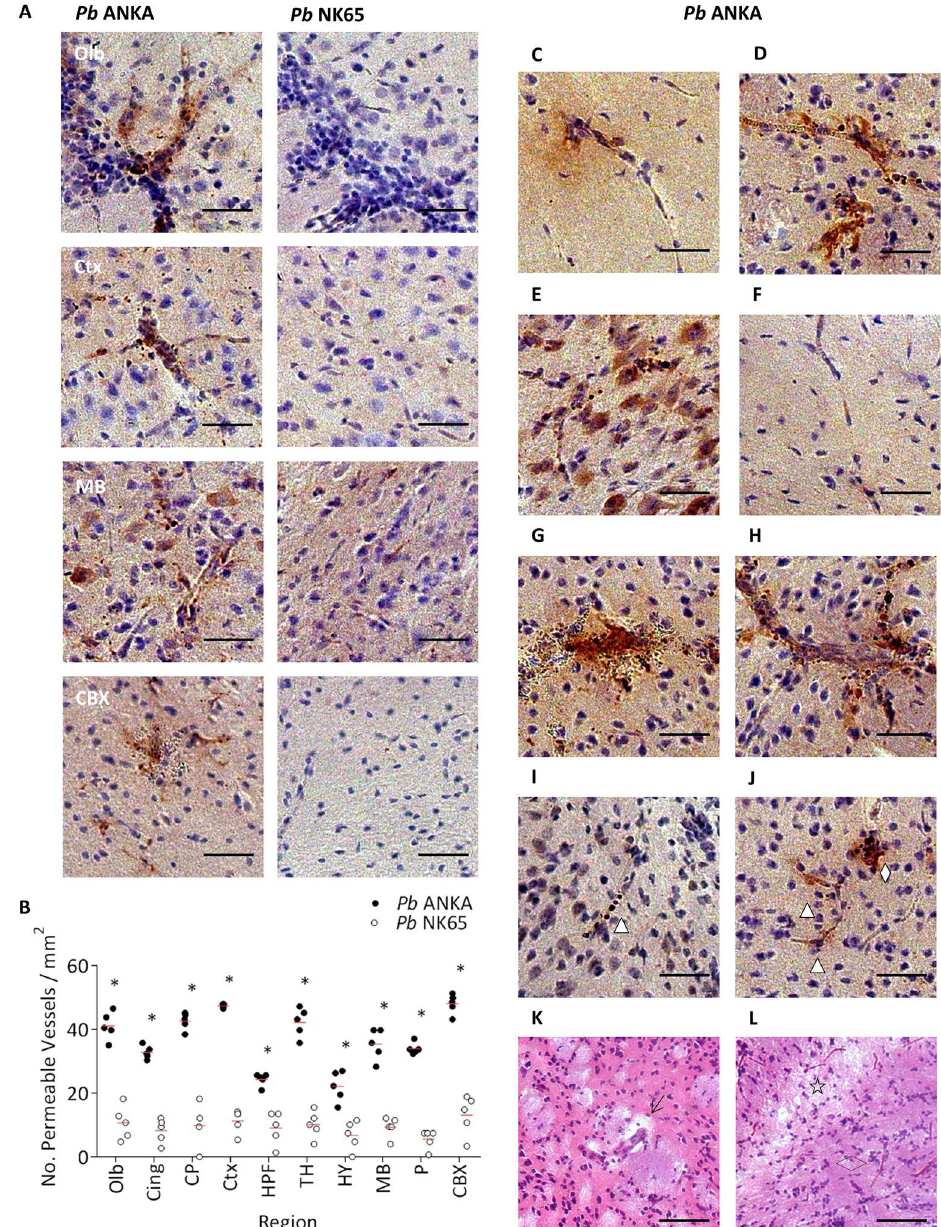
Fig 6. Cerebraloedema is more extensive during ECM infection compared to non-ECM infection. C57BL/6mice were infected with 1x10 4 Pb ANKA GFP (n = 5) or 1x10 4 Pb NK65 GFP (n = 5) pRBCs. Mice were culled at d7 p.i. when Pb ANKA infected mice exhibitedsigns of late-stage ECM. Brains were removed from transcardiallyperfused mice and BBB disruptionexaminedvia IgG immunohistochemistry. (A) Representative images from the olfactory bulbs, cortex, midbrainand cerebellarcortex showingthe relative prevalence of endogenousIgG in Pb ANKA and Pb NK65 infected mice. (B) Quantitation of permeable vessels within the different brain regions of Pb ANKA and Pb NK65 infected mice. Examples of vessels definedas permeableinclude: (C) vessel with a halo of IgGs; or (D) vessel associatedwith dense extravascular depositionsof IgG and IgG immunoreactive astrocytes. (E) IgG immunoreactive neurons. (F) Occludedvessel with intravascular IgG. Patterns of IgG stainingidentified: (G) haemorrhage; (H) vessels packed with leukocytes; (I) microvessel with arrested pRBCs; and (J) permeable vessels without directly associated vascular pathologicalfeatures ( Δ ), often, though, within the vicinity of vascular pathology ( ^ ). Histological types of oedema visualisedby H&E stainingincluding: (K) microvessel with dilated perivascular space ( " ) due to fluid accumulation; and (L) extensiveparenchymal oedema resulting in vacuolation